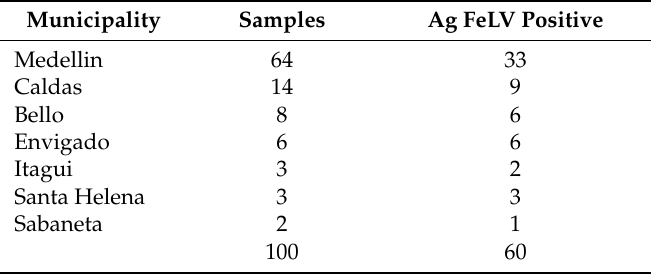
Table 3. Distribution of felines with FeLV positivity in Aburr á Valley,